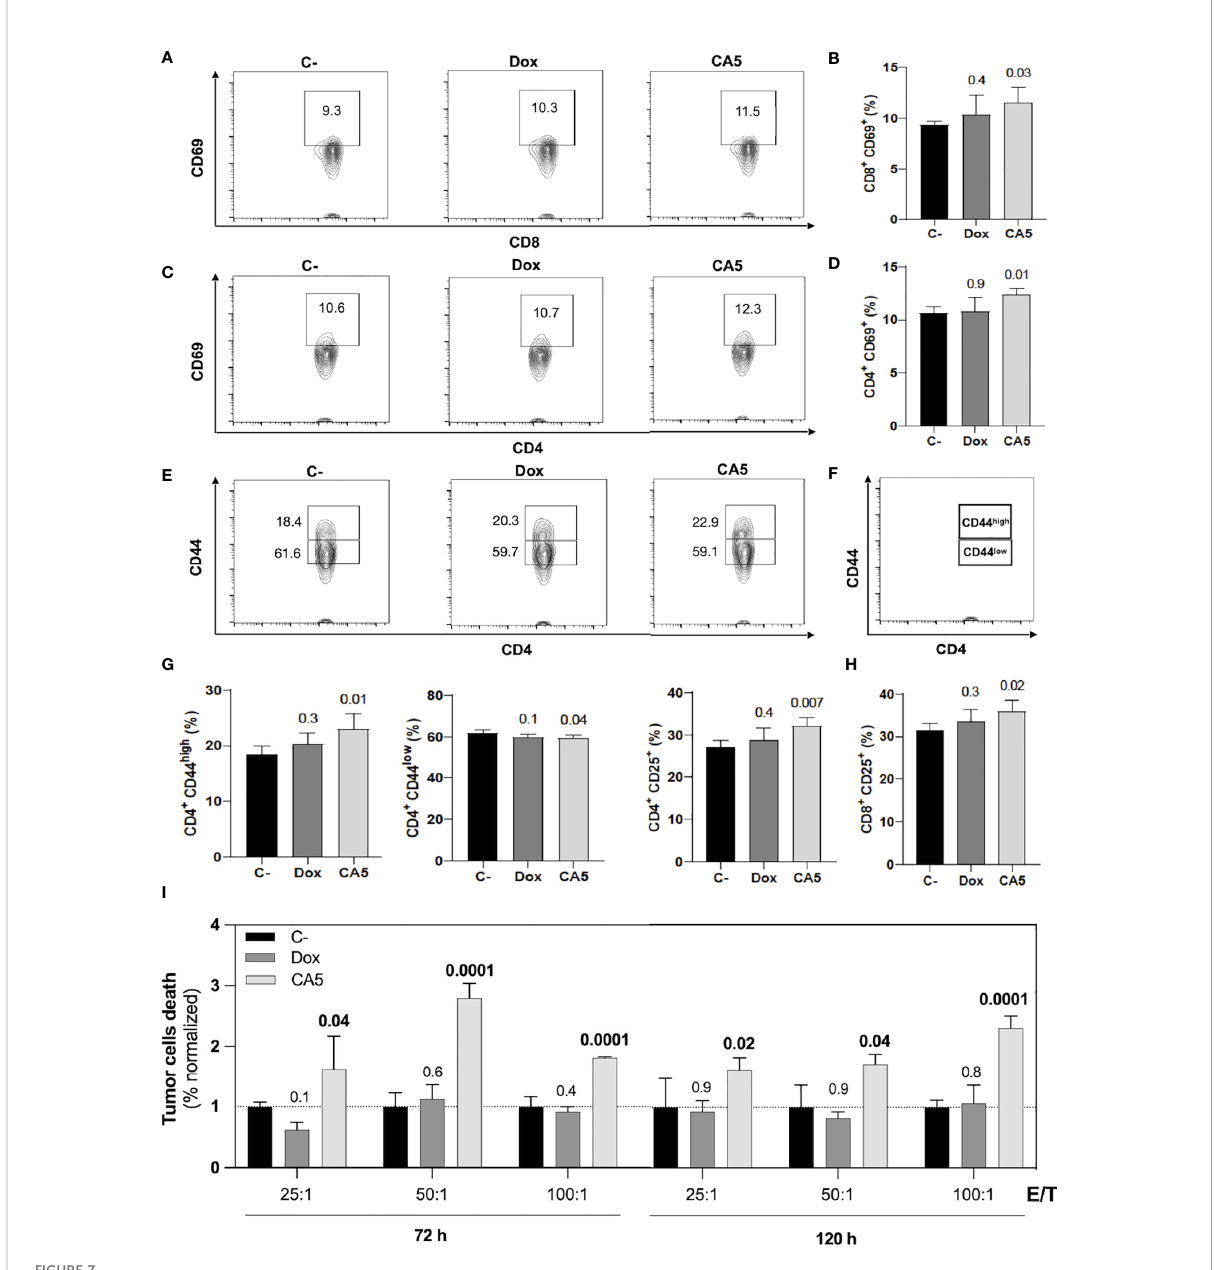
FIGURE 7 B16-F10 cells exposed to chromomycin A5 induce activation of CD4 + and CD8 + T lymphocytes and generate cell death in viable B16-F10 cells. Cells pre-incubated for 24 h with 0.1 m M CA 5 (CA5) and 0.6 m M doxorubicin (Dox), or sterile saline (C-) were injected subcutaneously in the right axilla of mice and their splenocytes were evaluated 7 days post-vaccination. (A) Representative contour plot graphs of CD69 surface marker on CD8 T lymphocytes. (B) Column graphs showing the percentage of CD8 + CD69 + T lymphocytes. (C) Representative contour plot graphs of the CD69 surface marker on CD4 T lymphocytes. (D) Column graphs showing the percentage of CD4 + CD69 + T lymphocytes. (E) Representative contour plot graphs of CD44 surface marker on CD4 T lymphocytes showing CD44 high and CD44 low populations and (F) illustration identifying CD44 high and CD44 low populations. (G) Column graphs showing the percentage of CD4 + CD44 high T lymphocytes, CD4 + CD44 low T and CD4 + CD25 + T lymphocytes and (H) column graphs showing the percentage of CD8 + CD25 + T lymphocytes. (I) Column graphs showing cell death of B16-F10 cells after 5h incubation with splenocytes ratios of effector/target (E/T). The splenocytes were previously restimulated with sterile saline (C-), CA5 and Dox for 72h and 120h before the cytotoxic assay. Differences between groups are expressed as p values indicated above the compared groups. N= 5 animals per